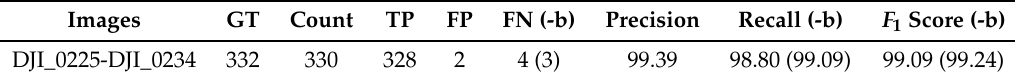
Table 4. Classification performance metrics for a sequence of 10 images (GT: ground-truth, TP: